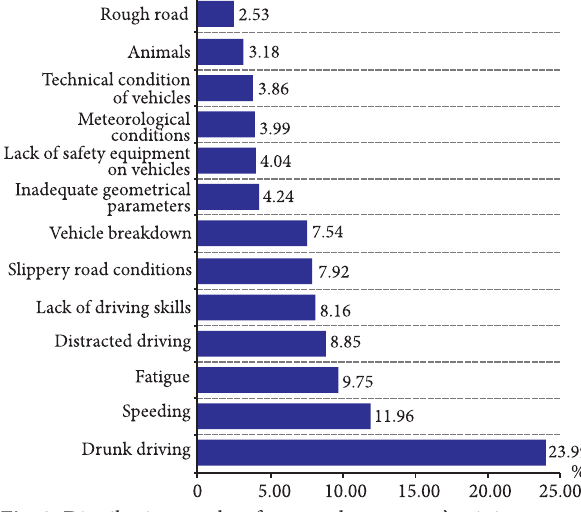
Fig. 2. Distribution results of summed up experts’ opinion on road accident